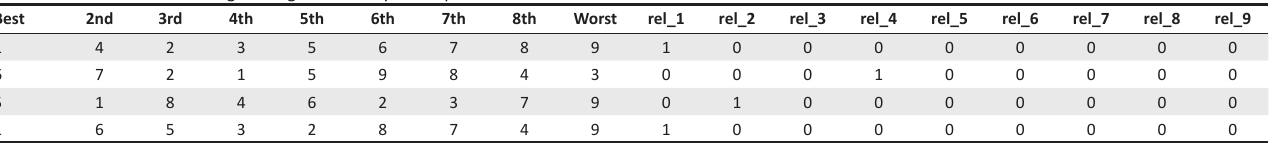
TABLE 1-A1: Data table showing ranking of reliability for respondents